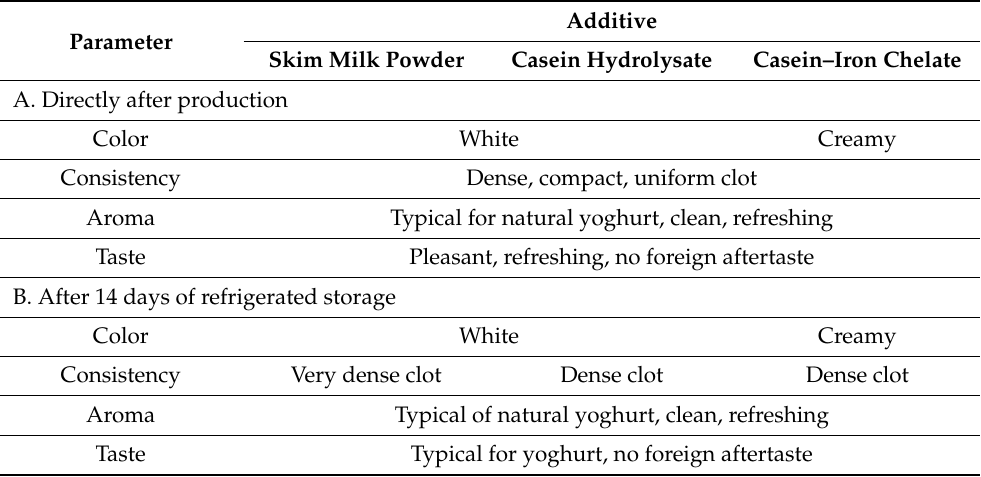
Table 5. Sensory analysis of yoghurts produced in various production variants directly after produc- tion (A) and after 14 days of refrigerated storage